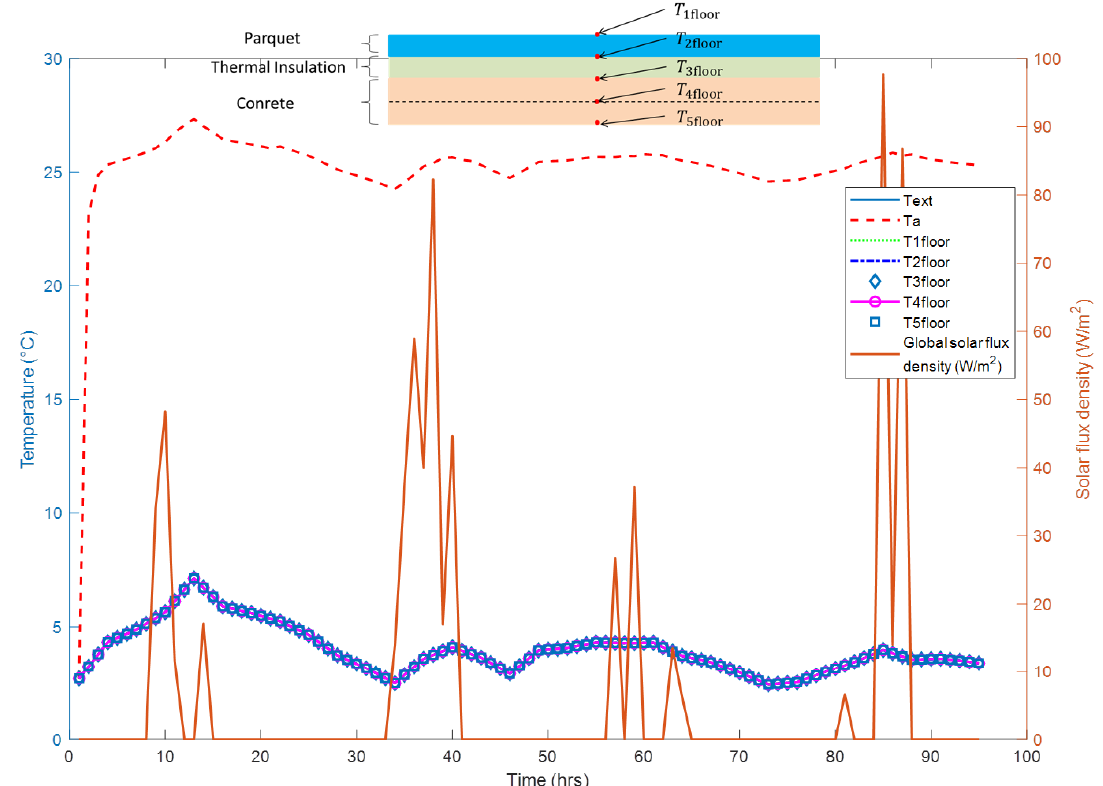
Figure 8. Global solar radiation with internal ambient and floor temperature dynamics profile.